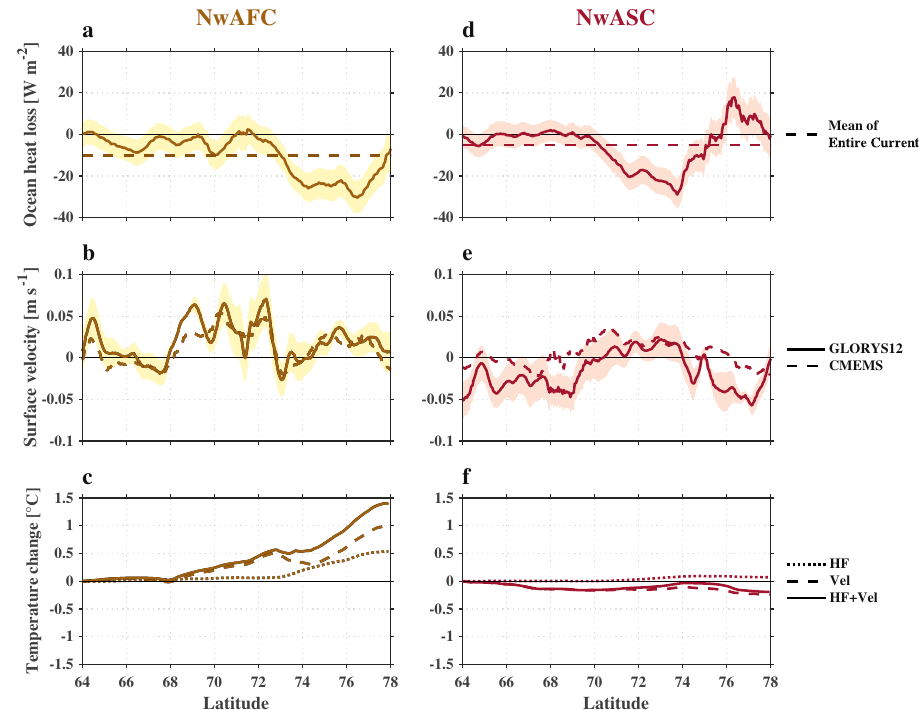
Fig. 5 | Long-term changes in surface heat loss and alongstream velocity, and their impacts. The left panels are the Norwegian Atlantic Front Current (NwAFC) andtherightpanelsaretheNorwegianAtlanticSlopeCurrent(NwASC).Thelayeris 0 – 200m. The solid lines in ( a , d ) show the long-term net changes of year-round mean air – sea turbulent heat fl ux along the two currents (from 1993 to 2018), with thestandarderrorshaded.Thedashedlinedenotesthemeanchangefortheentire current. The solid and dashed lines in ( b , e ) show the long-term net change (from 1993 to 2018) of sea surface alongstream velocity from the reanalysis product